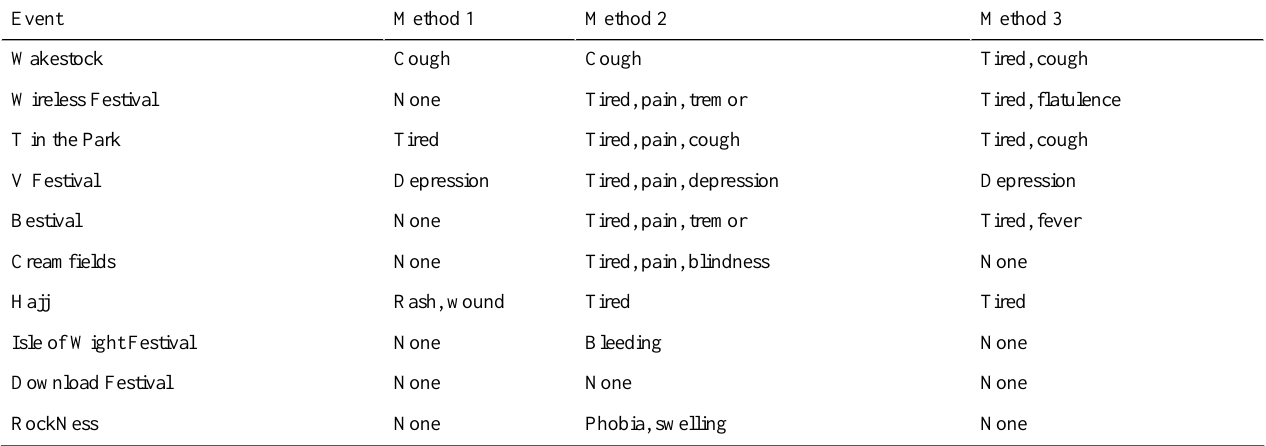
Table 4. Statistically significant symptoms a from Twitter data for each event and three analysis